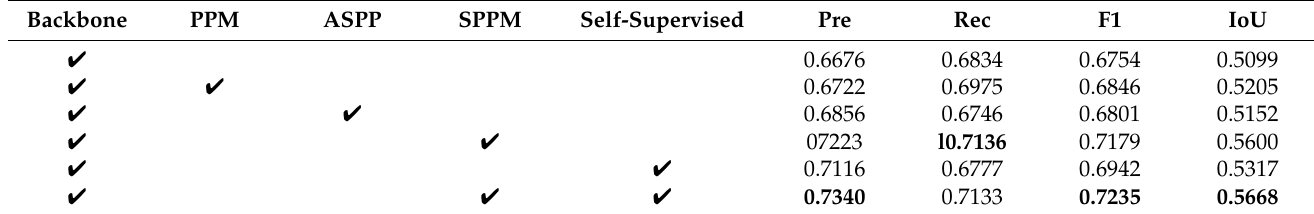
Table 3. Ablation